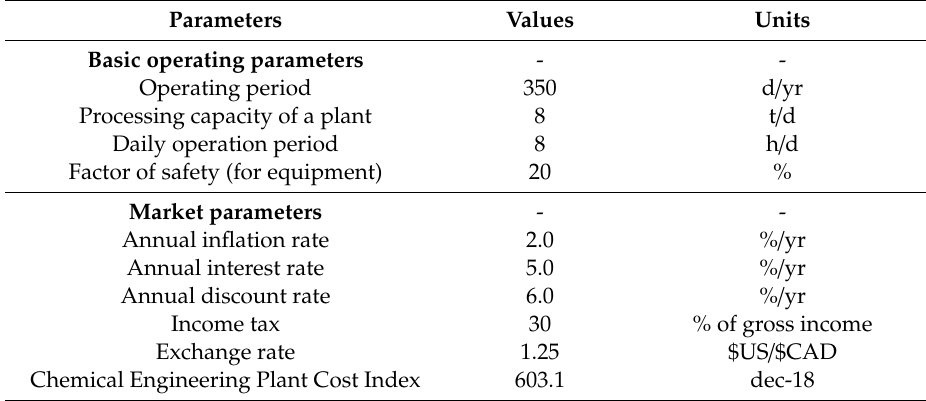
Table 2. Basic operating parameters, market parameters, and capitalization parameters of the techno-economic model for recycling spent alkaline